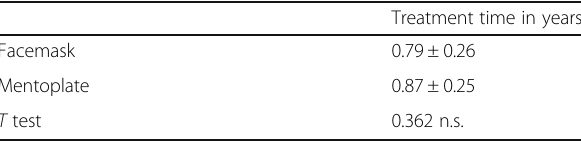
Treatment time in years